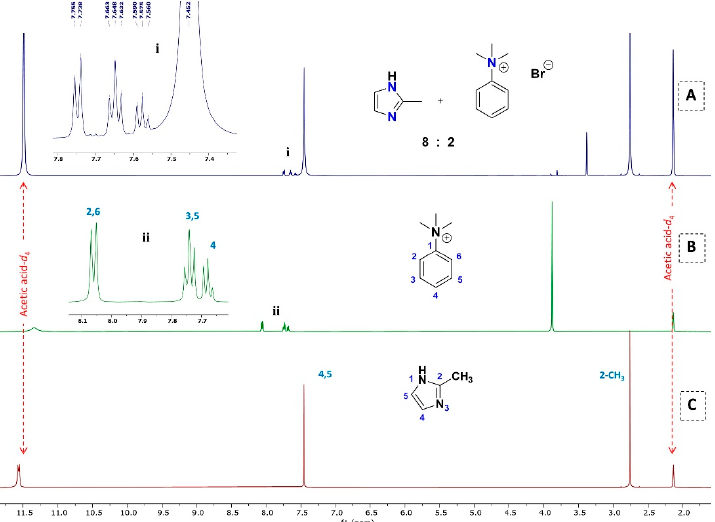
Figure 11. 1 H NMR spectra (in CD 3 COOD) of (A) ZIF-8, (B) TMPAB salt and (C) 2-methylimidazole.